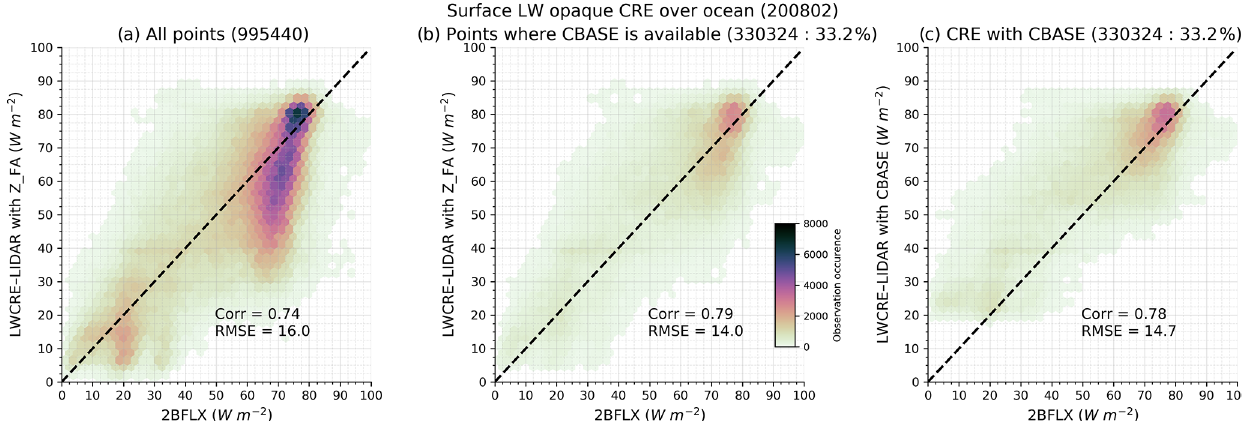
Figure 16. Surface LW CRE derived from LWCRE–LIDAR as a function of the one derived from 2BFLX. (a) Surface LWCRE–LIDAR ( y axis) computed using the altitude of full lidar attenuation (b) , same as (a) but containing only the subsample of CALIPSO profiles where cloud-base-height values are available from Mülmenstädt et al. (2018). (c) Same as (b) , but the surface LWCRE–LIDAR is computed using the cloud-base-height values from Mülmenstädt et al. (2018) instead of the altitude of lidar full attenuation. The color scale indicates the number of occurrences at 5km resolution (footprint scale of CloudSat) over ocean in February